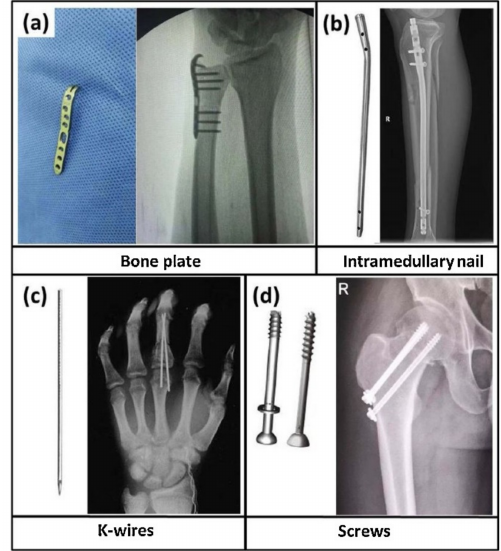
Figure 2. Examples of bone fixation devices: ( a ) a bone plate, ( b ) an intramedullary nail, ( c ) a K-wire, and ( d ) screws. Reprinted from Materials evolution of bone plates for internal fixation of